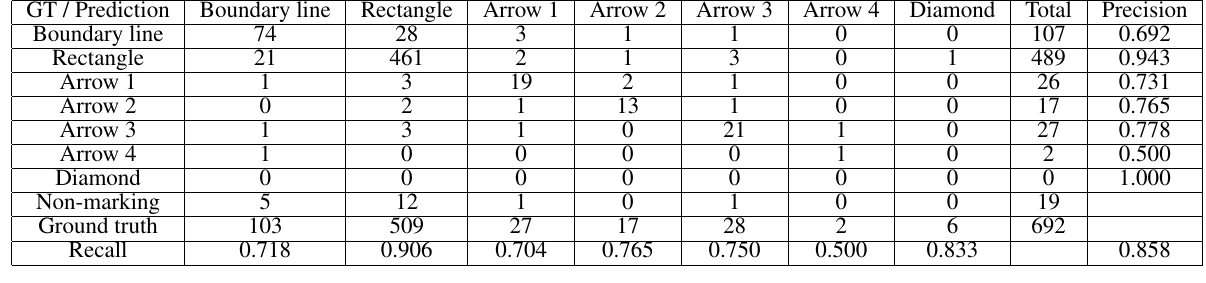
Table 3. Confusion Matrix for road markings classification for Urban road 1 dataset